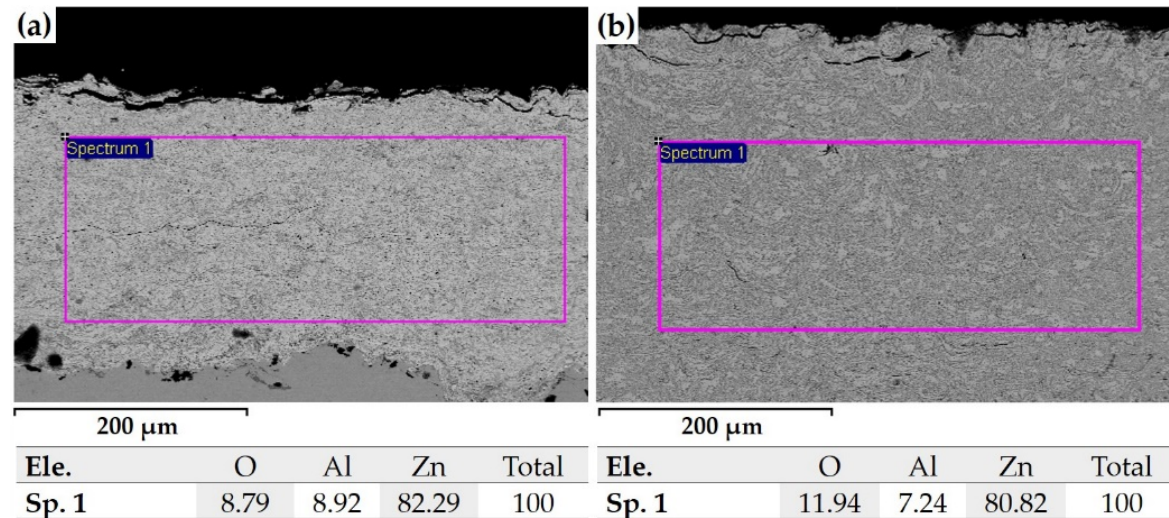
Figure 3. SEM micrographs of ZnAl4 coatings with EDX area scans and element concentration ( a ) using compressed air and ( b ) using argon as atomization gas.